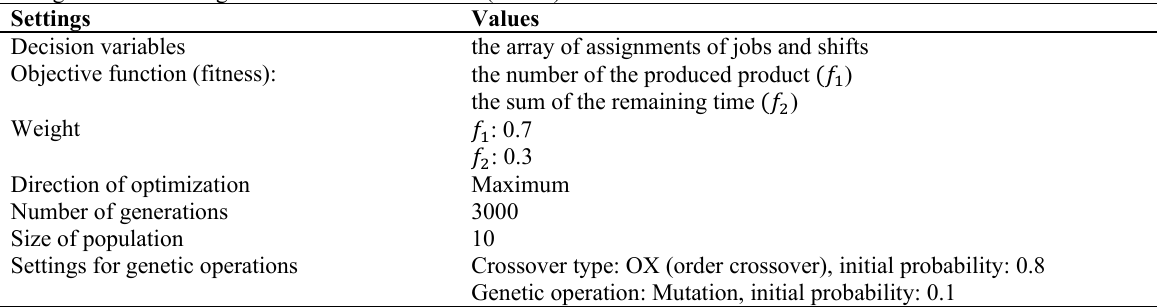
Settings for Genetic Algorithm of Plant Simulation (PSGA) Settings Values Decision variables the array of assignments of jobs and shifts Objective function (fitness): the number of the produced product ( 𝑓